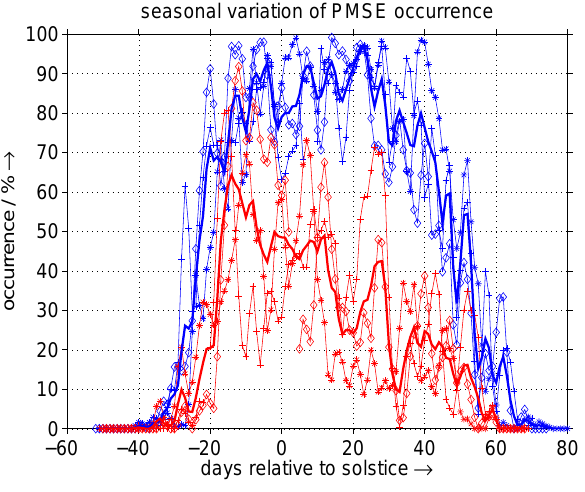
Fig. 9. Seasonal variation of PMSE occurrence above Andenes (2004–2006, blue) and Davis (2004/2005–2006/2007, red) based on radar volume reflectivities ≥ 1 × 10 − 15 m − 1 . The thin lines with symbols represent the individual years: + 2004 (2004/2005), ? 2005 (2005/2006), and (cid:5) 2006 (2006/2007). Table 3. Onset and end of seasonal occurrence of PMSE observed at Andenes and Davis.